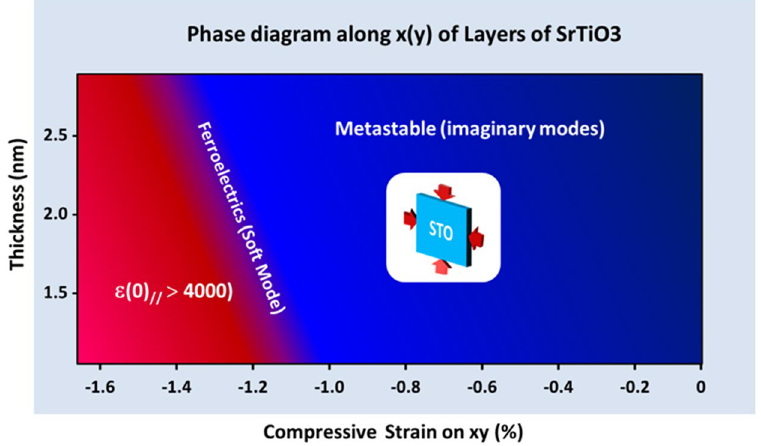
Figure 5. Schematic thickness-strain phase diagram based on DFT analysis for STO ultrathin films at room temperature. The strain is varied between − 1.69% (Si (001) induced strain) and 0% (fully relaxed) and thickness between 0.5 and 2.5 nm. The ferroelectrics transition corresponds to the zeroing of a soft mode. The metastable phase corresponds to the development of an imaginary